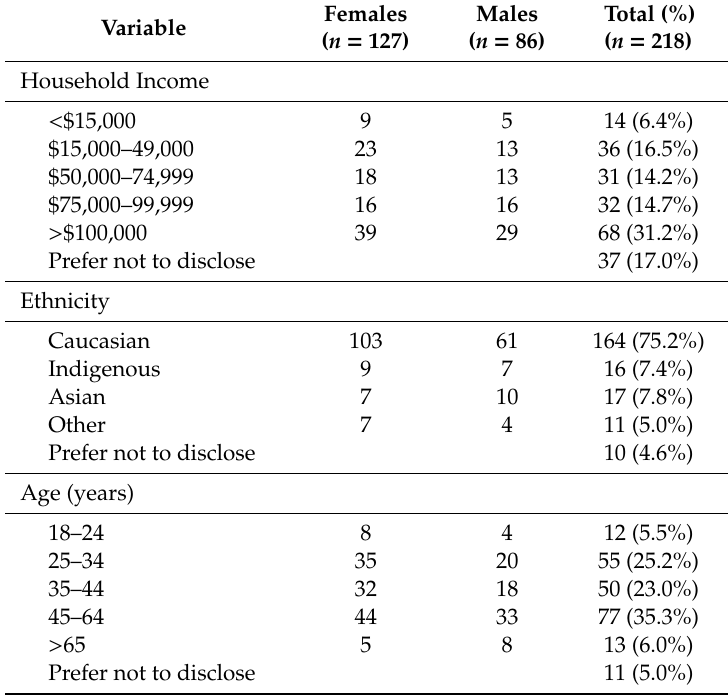
Table 2. Trail user